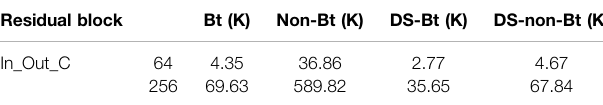
TABLE 1 | Number of module parameters with different